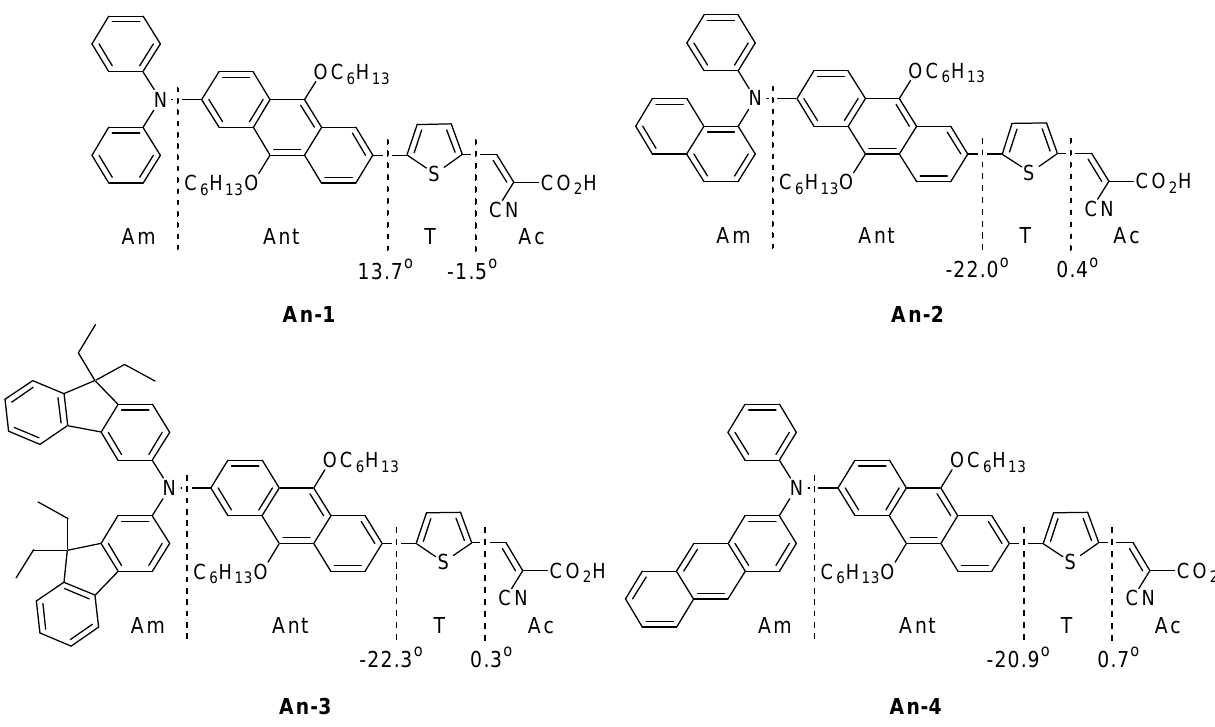
Figure 9. Schematic division and dihedral angles of molecules.